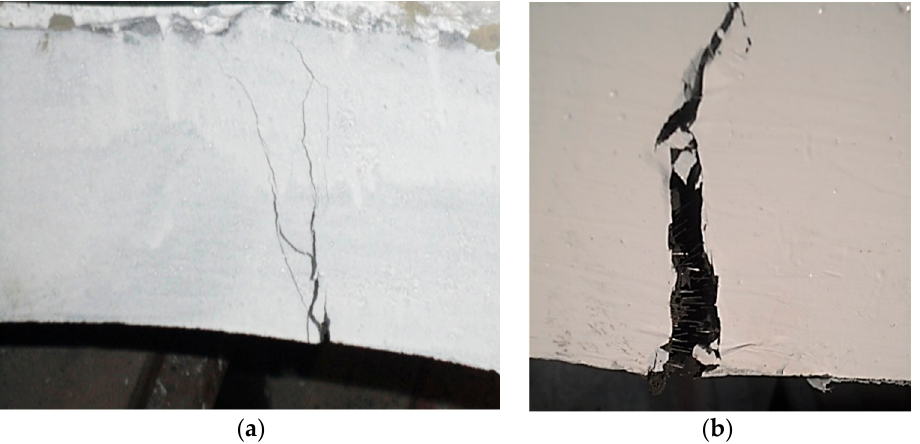
Figure 8. Cracking of UHPC segments along the thickness: ( a ) Cracks developed during testing; ( b ) Single macro crack leading to failure of the segment.